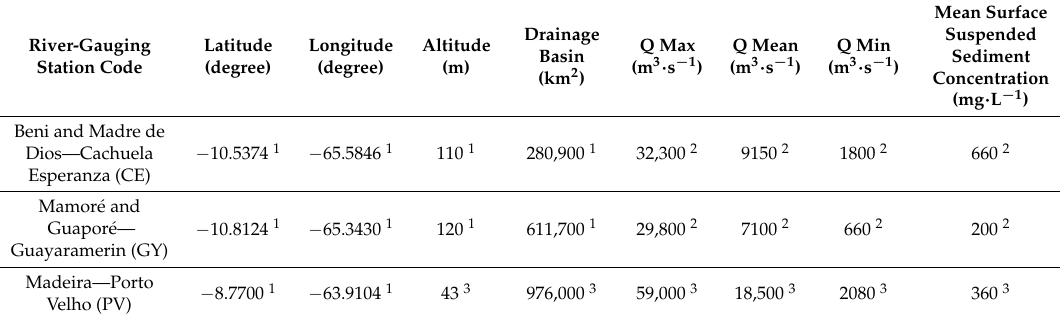
Table 1. Gauging station characteristics for